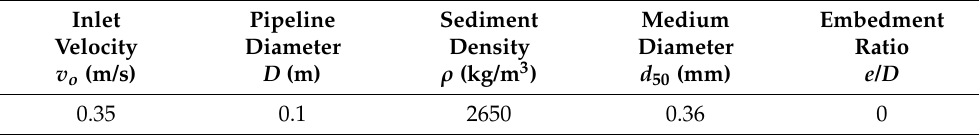
Table 1. 2D single-pipeline scour model parameters.